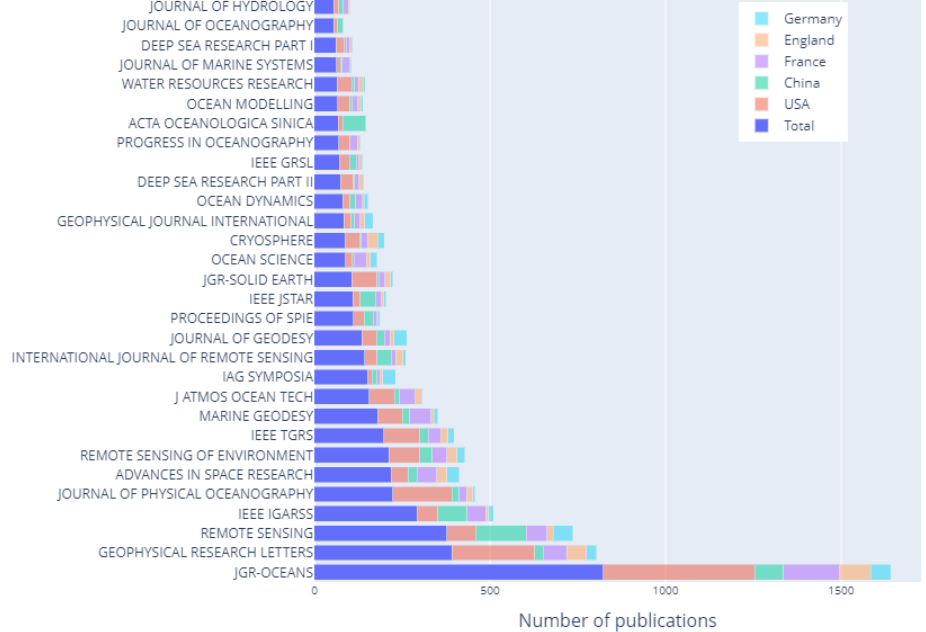
Figure 1. Histogram of the number of papers published within several journals using keywords (i.e., Geodetic Time Series, GNSS time series, Crustal Deformation Geodesy, Environmental Monitoring, InSAR Geodesy, Machine Learning Geodesy, Sea Level Rise Geodesy, Tectonic Activity Geodesy and Terrestrial Laser Scanners Geodesy). The source of the statistics is web of science.